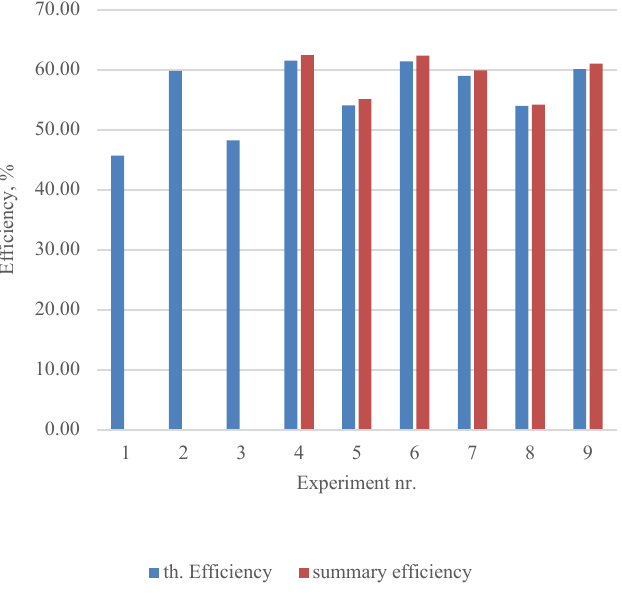
Fig. 7. Thermal and summary CHP mode efficiency